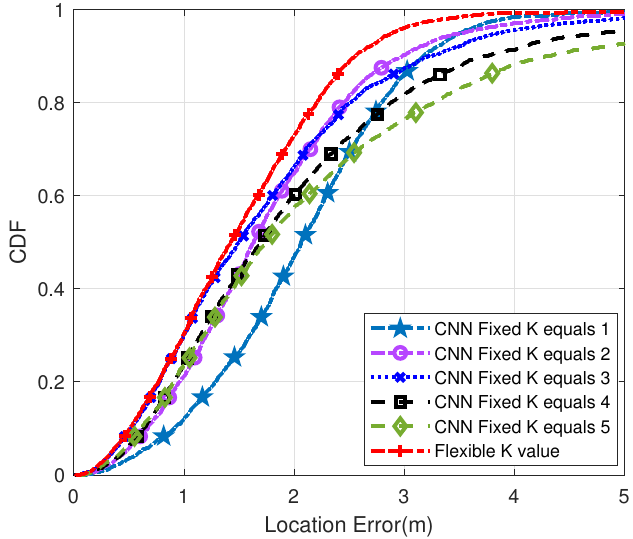
Figure 8. Probability distribution diagram of positioning error when the distance between two reference points is 5 m (Q =